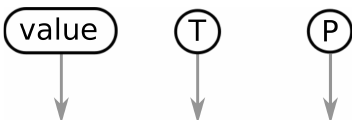
Figure 2.37: The Entity Relationship glyph for variable value